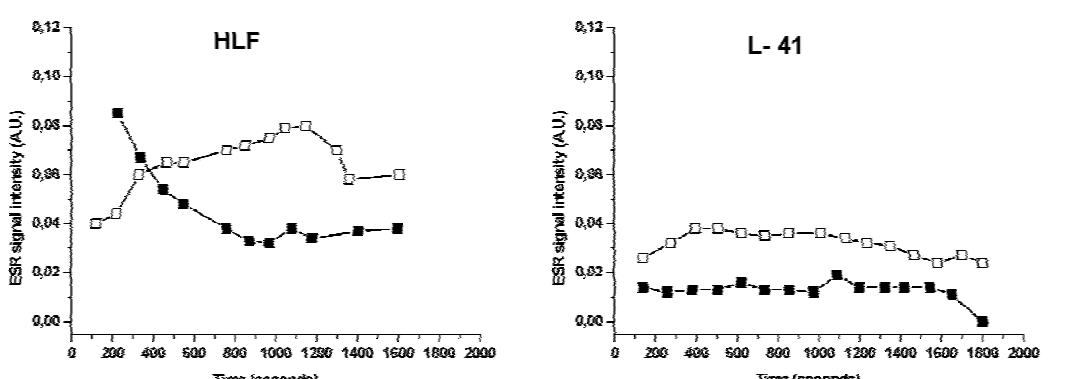
final volume 62.5 µ l.